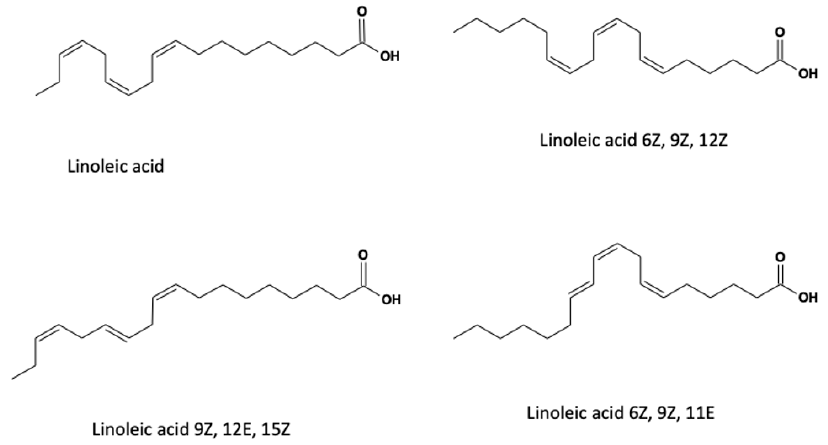
Figure 5. Linoleic acid isomers found in S. hispanica during seeds imbibition.